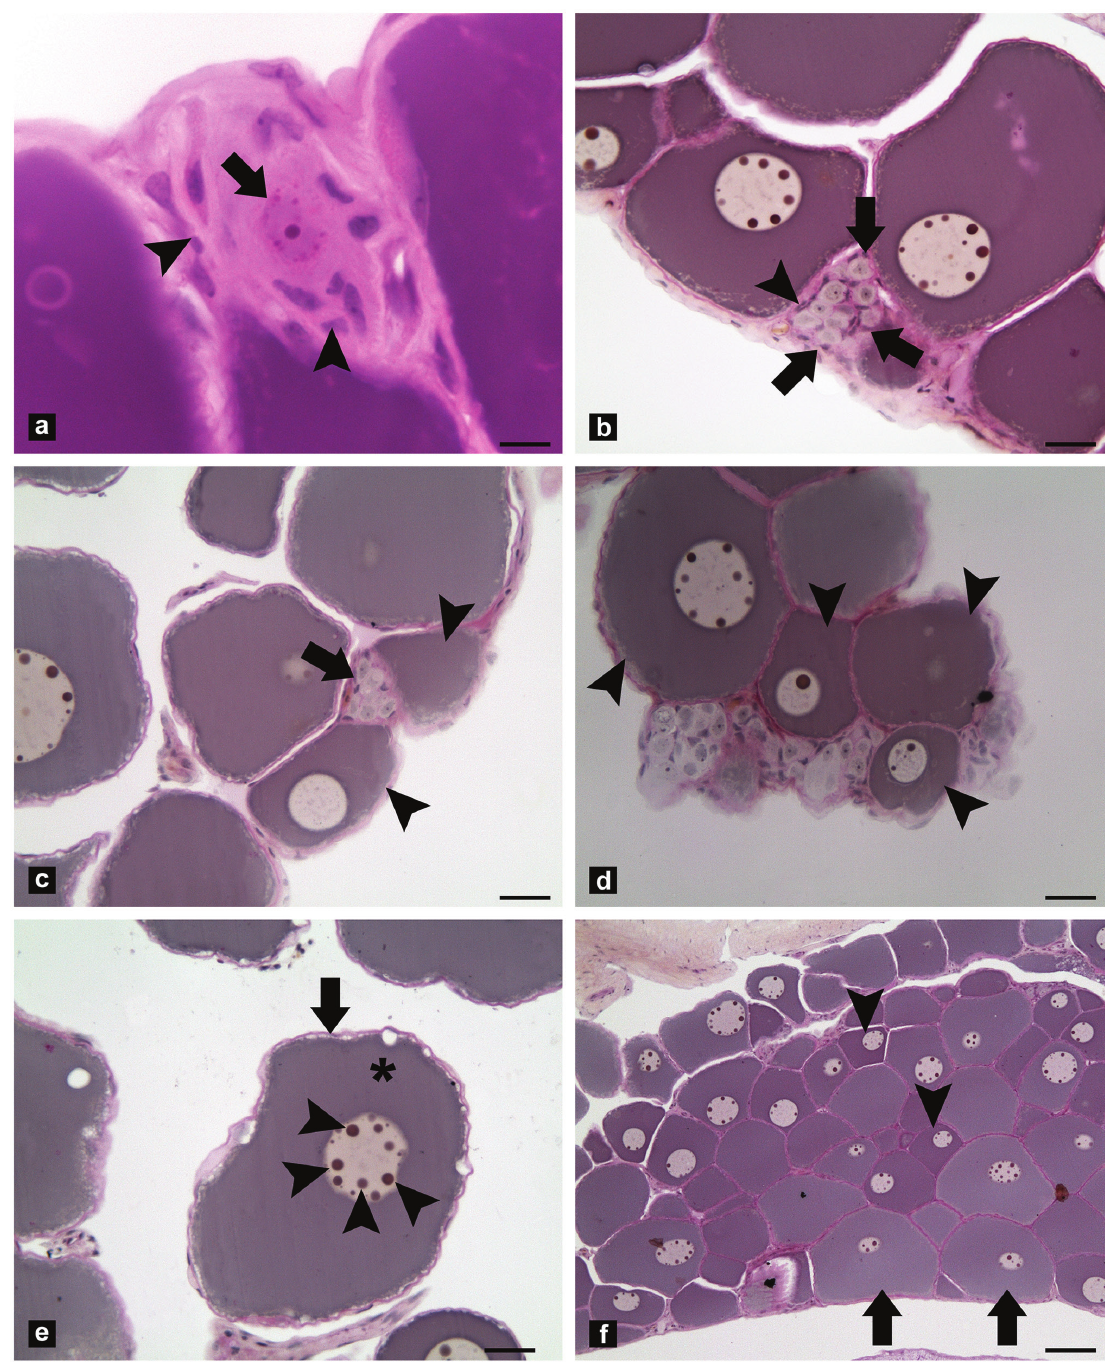
Fig. 1. Micrographs of the ovaries of Steindachneridion parahybae juveniles in captivity showing different germ cell types. a) scattered oogonia (arrow) within the germinal epithelium surrounded by prefollicle cells (arrowhead); b) proliferation of the oogonium gives rise to cell cluster that appears as small nests (delimited by the arrows), and are also surrounded by prefollicle cells (arrowhead); c) inside this nests, oogonia (arrow) enter into meiosis and progressively individualized by cells derived from the epithelium (prefollicle cells), and they become separated from nests, originating the oocytes (arrowhead); d) following the ovarian development, early primary growth or perinucleolar oocyte (arrowhead) is characterized by an enhancement of cytoplasm basophilia; e) Perinucleolar oocyte (asterisk) showing the thin follicular layer (arrow) and multiple nucleoli displaced in a perinuclear position (arrowhead); f) Perinucleolar stage in different size, showing in an initial (arrowhead) and advanced stage (arrow). Periodic-Acid-Schiff (PAS)/Weigert’s Haematoxylin/Metanil Yellow staining. Scale bars: 10 µm (a); 30 µm (b,c,d,e); 400 µm